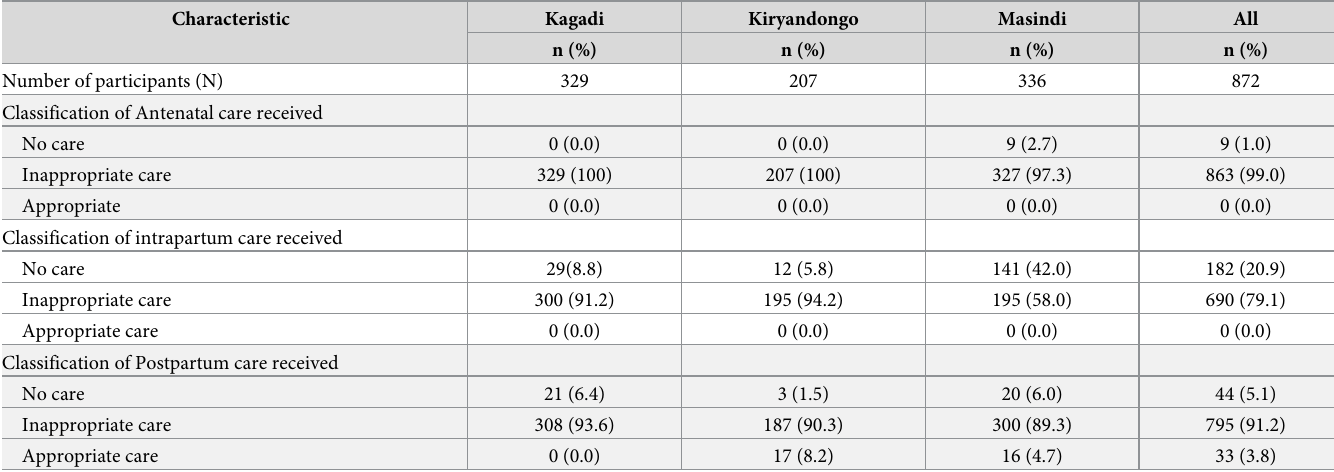
Table 2. Prevalence of inappropriate perinatal